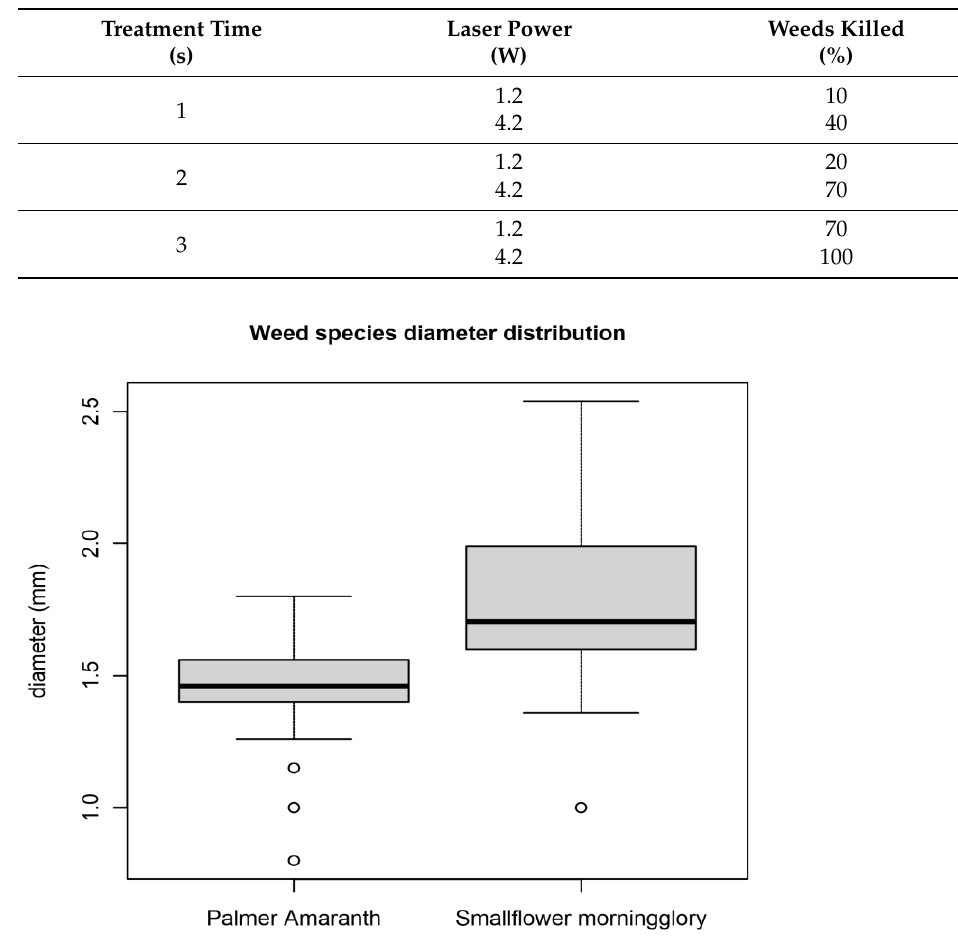
Table 2. Percentage of weeds killed after 1 week of monitoring.